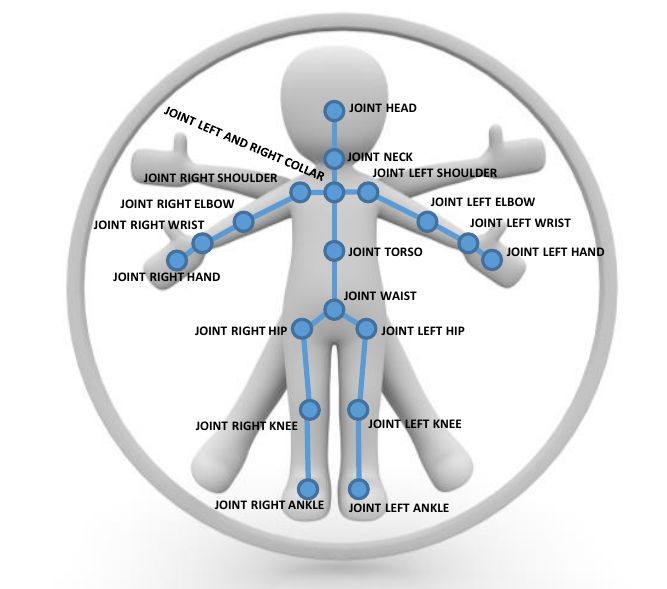
Figure 5. An illustration of the Nuitrack SDK pose representation using 20 joints with edges corresponding to the bones in between to represent human poses.